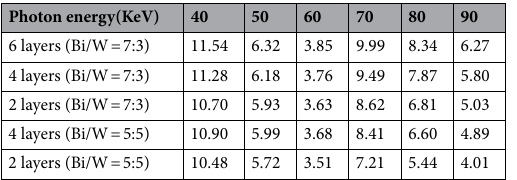
Table 3. The mass attenuation coefficient (μ/ρ cm 2 ·g −1 ) of the X-ray transmittance on layer thickness ratios (7:3 and